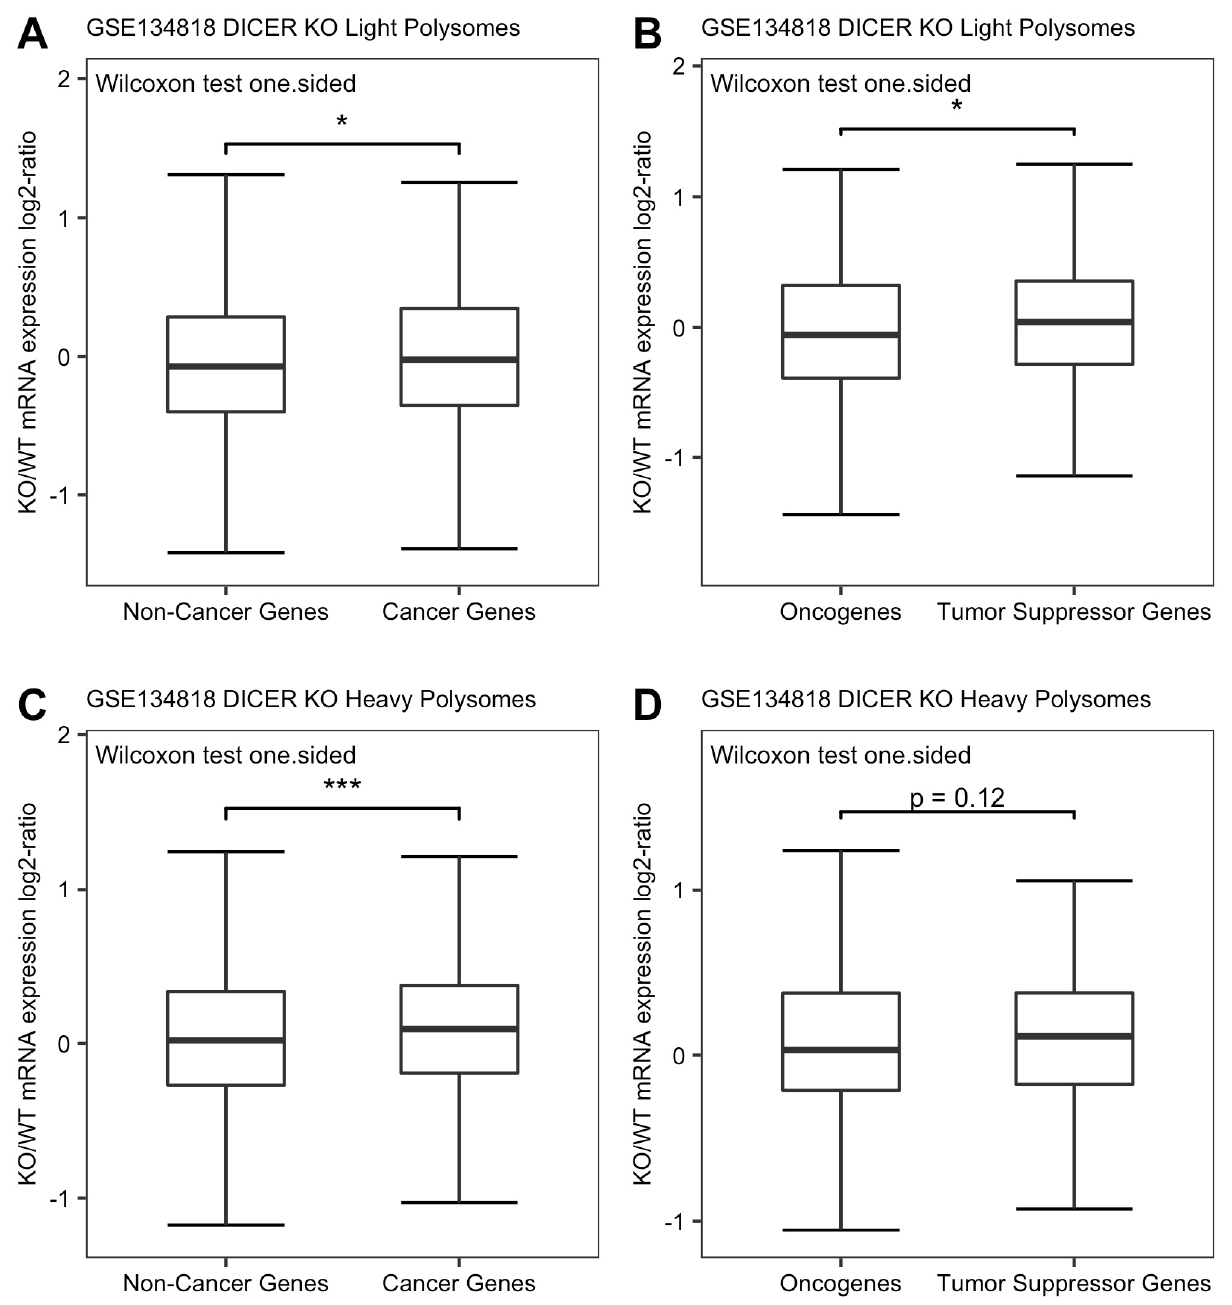
Figure 6. ( A ) Average light polysomes associated mRNA expression changes of total protein-coding genes and 828 cancer genes in Dicer1 knockout human HCT116 cells ( p -value = 0.015 by one-sided Wilcoxon rank-sum test). ( B ) Average light polysomes associated mRNA expression changes of 413 oncogenes and 415 TSGs in Dicer1 knockout human HCT116 cells ( p -value = 0.032 by one-sided Wilcoxon rank-sum test). ( C ) Average heavy polysomes associated mRNA expression changes of total protein-coding genes and 828 cancer genes in Dicer1 knockout human HCT116 cells ( p -value = 0.00086 by one-sided Wilcoxon rank-sum test). ( D ) Average heavy polysomes associated mRNA expression changes of 413 oncogenes and 415 TSGs in Dicer1 knockout human HCT116 cells ( p -value = 0.12 by one-sided Wilcoxon rank-sum test). (“*” indicates p < 0.05, “***” indicates p < 0.001).